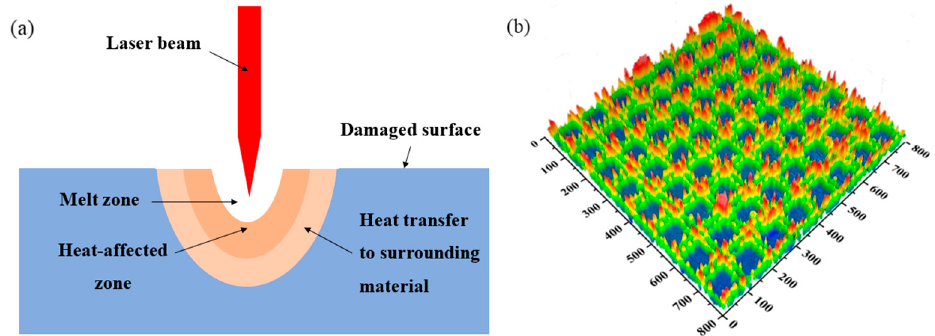
Figure 6. ( a ) The schematic diagram of the laser surface texturing; ( b ) The three-dimensional topography of the groove of nickel with an energy density of 100 J/cm 2.